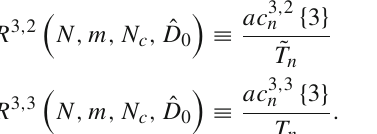
harmonic over experimental data was taken with momenta varying in two different kinematic regions k ∈ [0 . 3 , 3] GeV and k ∈ [0 . 5 , 5] GeV